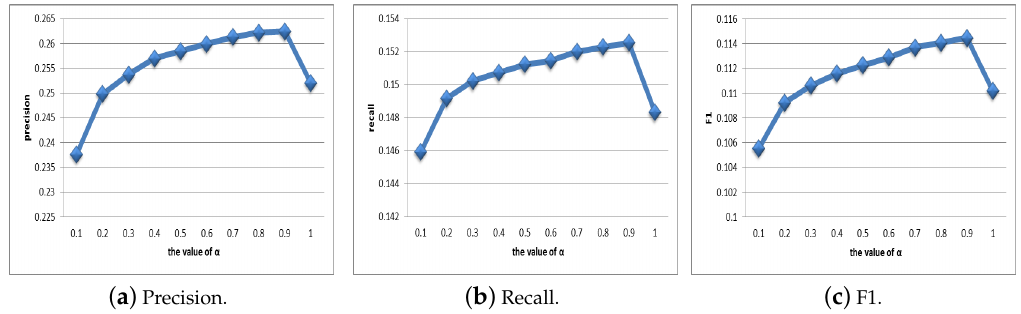
Figure 4. Selection of Parameter α . ( a ) Description of Precision in the first panel. ( b ) Description of recall in the second panel. ( c ) Description of F1 in the third panel.